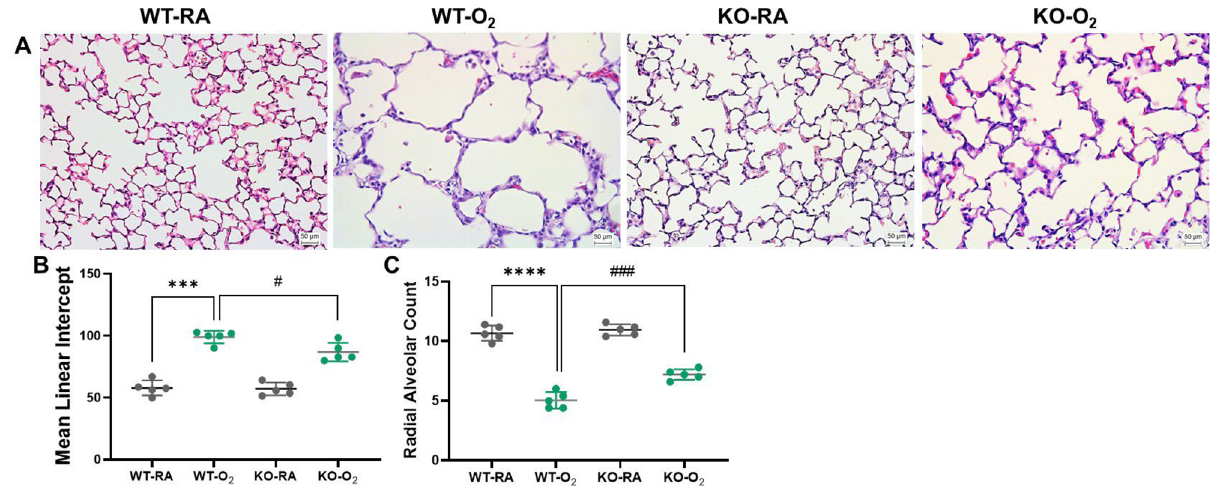
Figure 2. ( A ) Representative H&E stained lung tissue sections from WT-RA, WT-O 2 , KO-RA, and KO-O 2 mice. Larger and simplified alveolar structures were observed in the lungs of the WT-O 2 group. ( B ) Alveolarization was assessed by counting MLI, which showed an increased MLI in the WT-O 2 group, while the GSDMD-KO group exposed to hyperoxia had a decreased MLI. ( C ) RAC was decreased in the hyperoxia- exposed WT lungs but increased in the hyperoxia-exposed GSDMD-KO lungs compared to hyperoxic WT